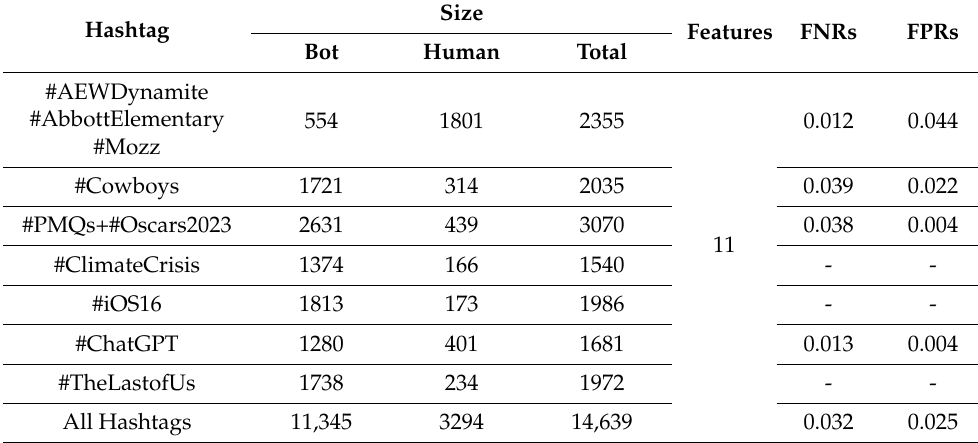
Table 6. PAC framework results of SEBD using epsilon = 0.05 and delta = 0.05.